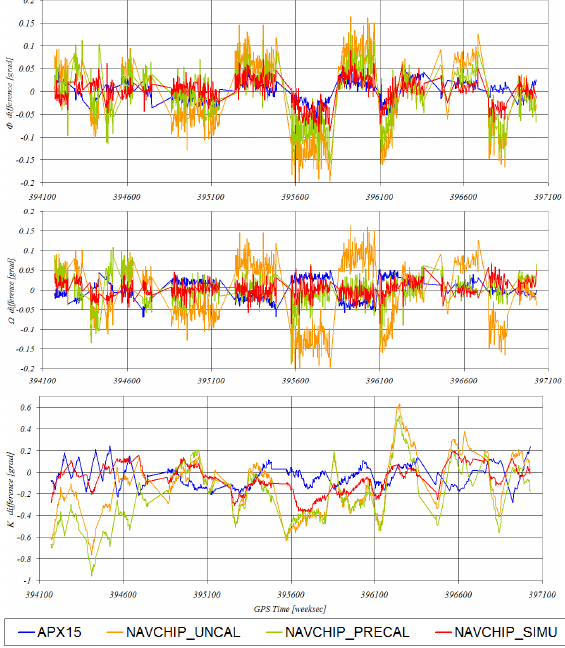
Figure 6: Angular difference in [grad] between APX15/Navchip and AIRINS for each image projection centre after suppression of boresight. (PHI/pitch (top), OMEGA/ROLL(middle), KAPPA/Heading(bottom)